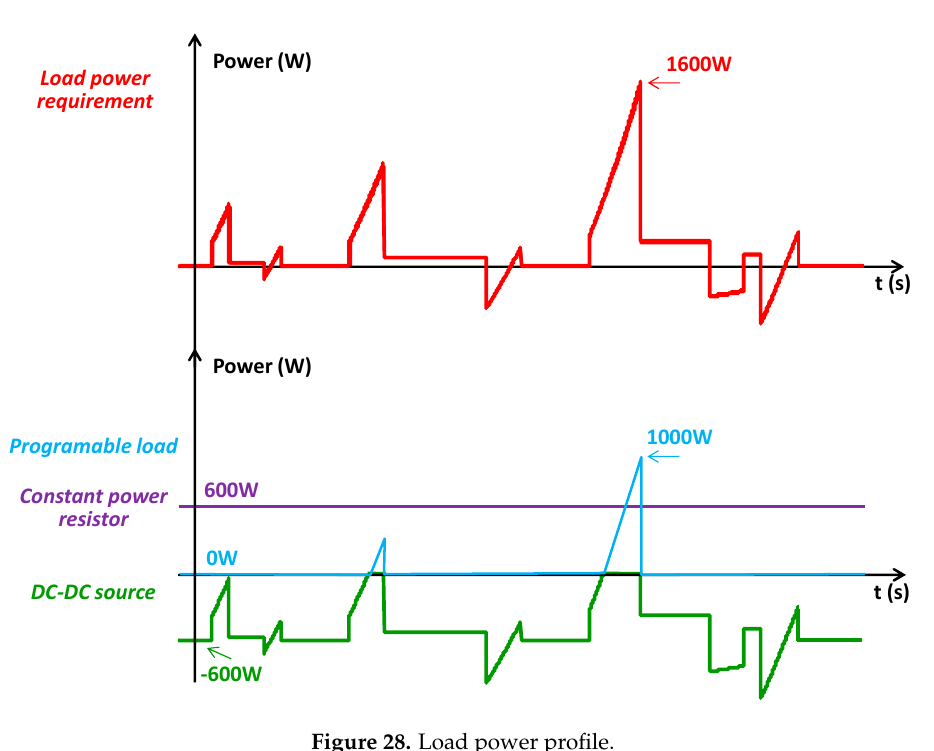
Figure 28. Load power profile.